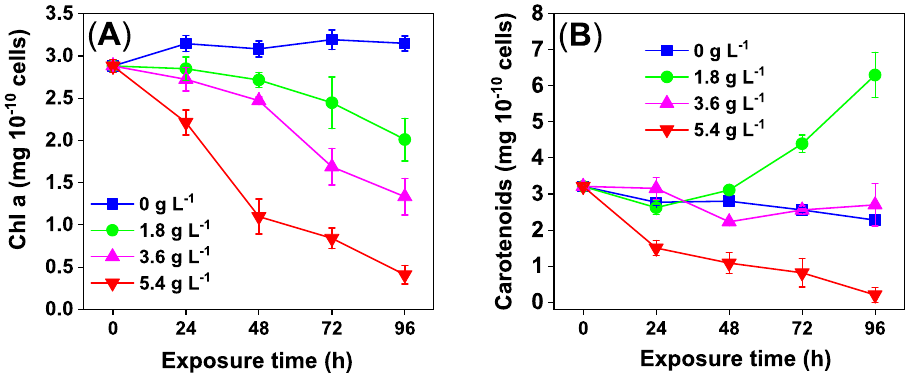
Figure 5. Chlorophyll a (Chl a) and carotenoid in Dolichospermum flos-aquae cells under the stress of aqueous extract of watermelon peel (WMPAE) (Data are shown as mean ± standard deviation for n = 3).